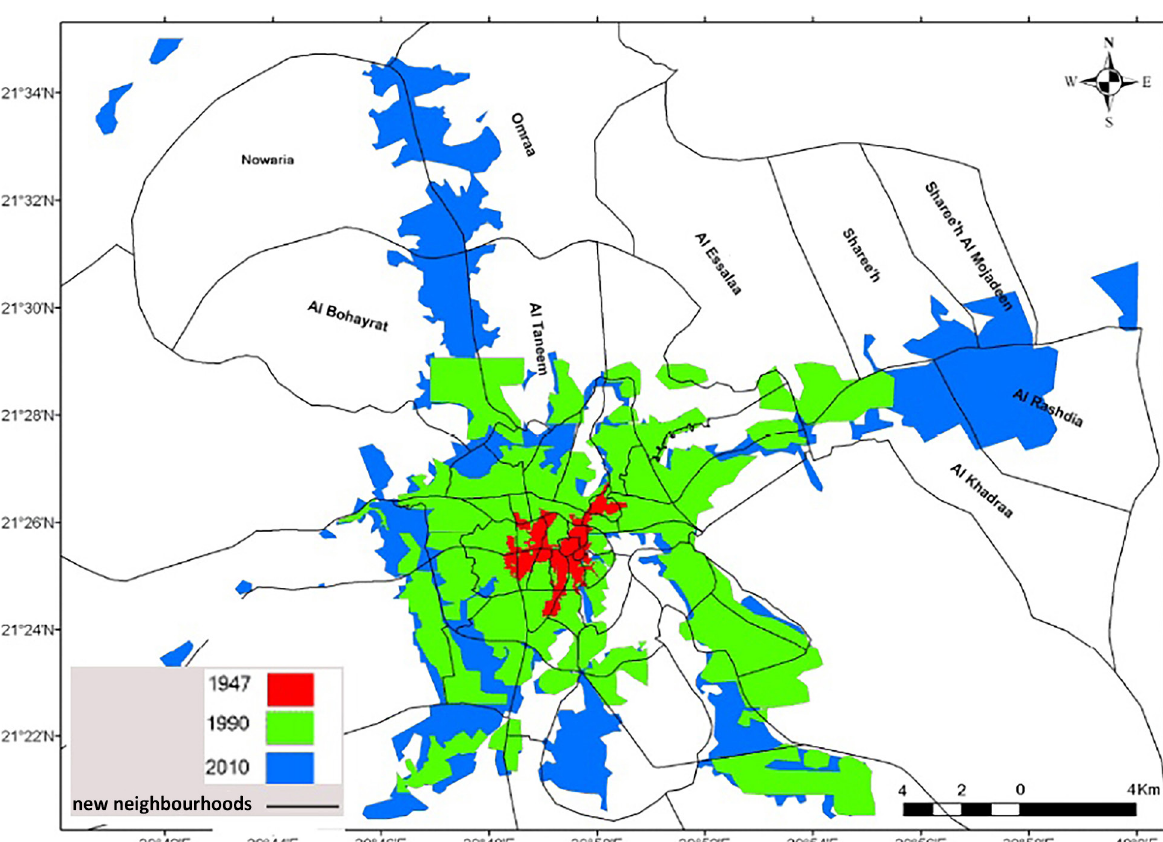
Fig. 4. Concentration of the population around Haram.